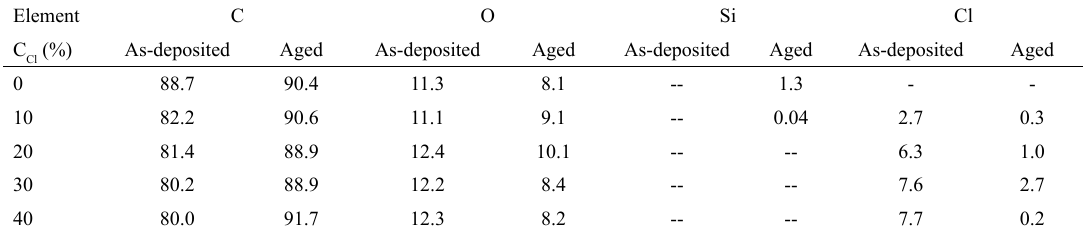
, the percentage of chloroform in the feed, for the as-deposited and aged films. Cl